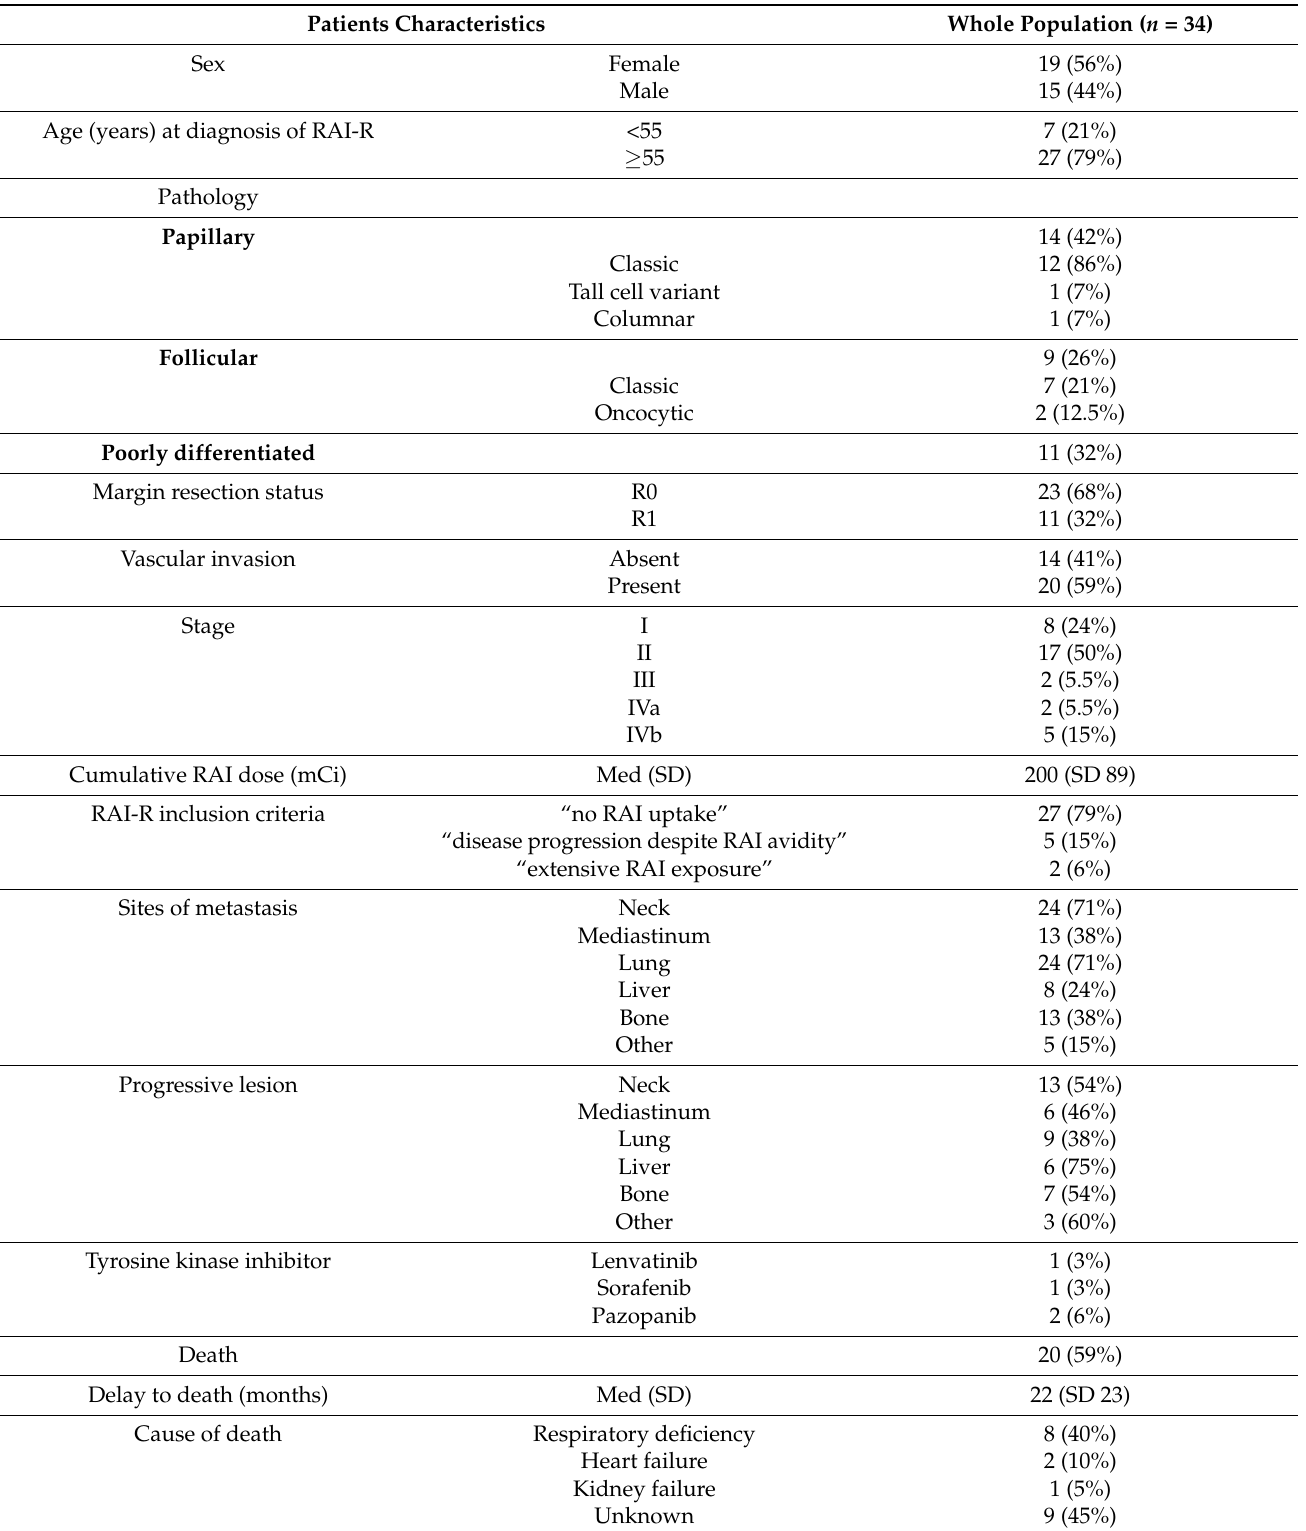
Table 1. Patients clinical characteristics for the whole population ( n =